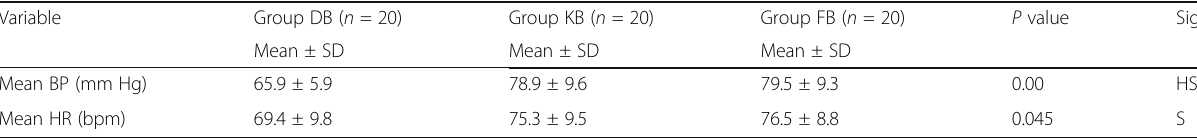
Table 2 Mean blood pressure and heart rate Variable